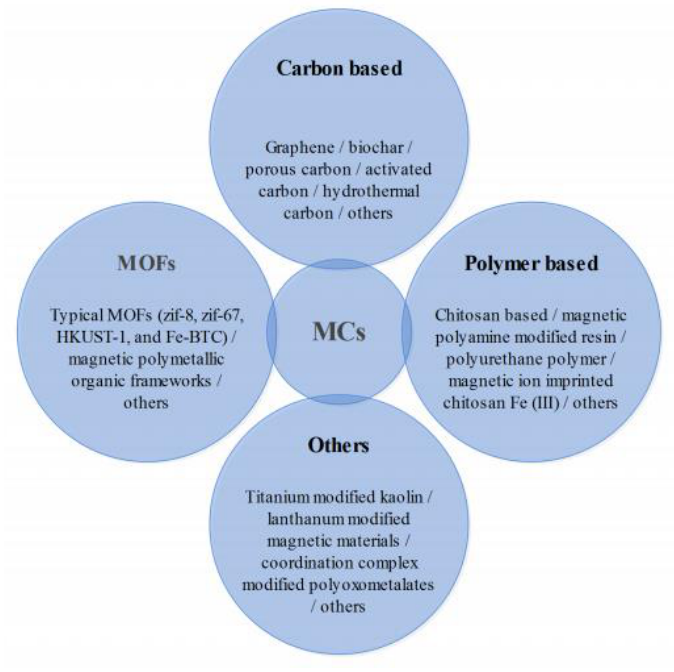
Figure 2. Categories of magnetic composites.